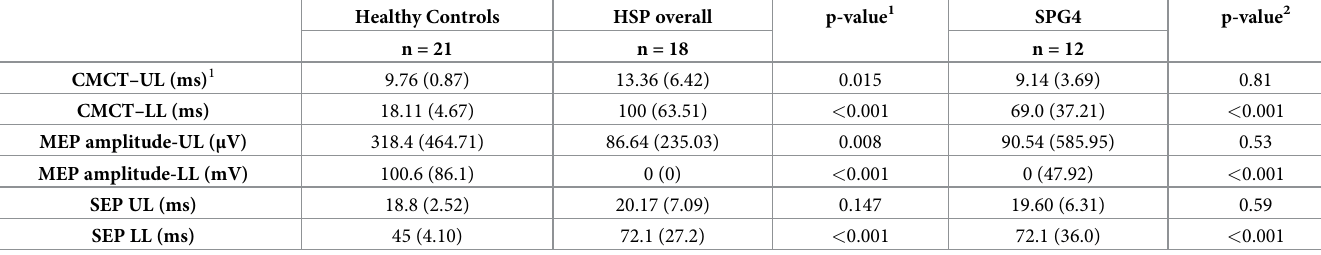
Table 2. Main motor and somatosensory evoked potentials findings.